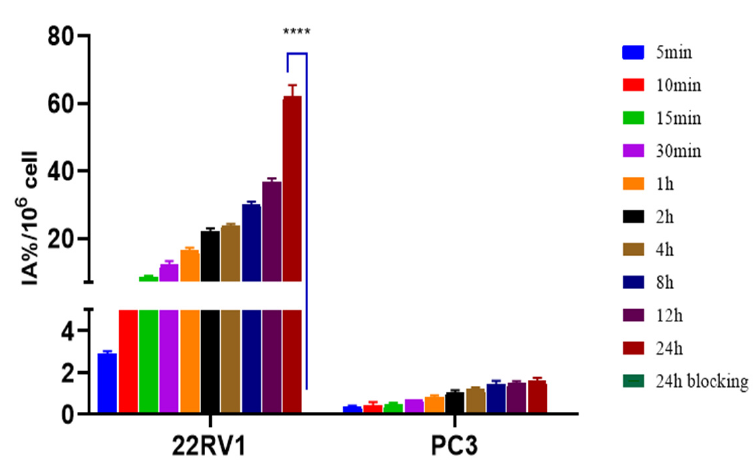
Figure 8. Cell uptake of 125 I-PSMA-7 in 22Rv1 and PC3 cells at different time points. **** represents a significant difference between the 24h uptake and 24h blockade of the 22RV1.